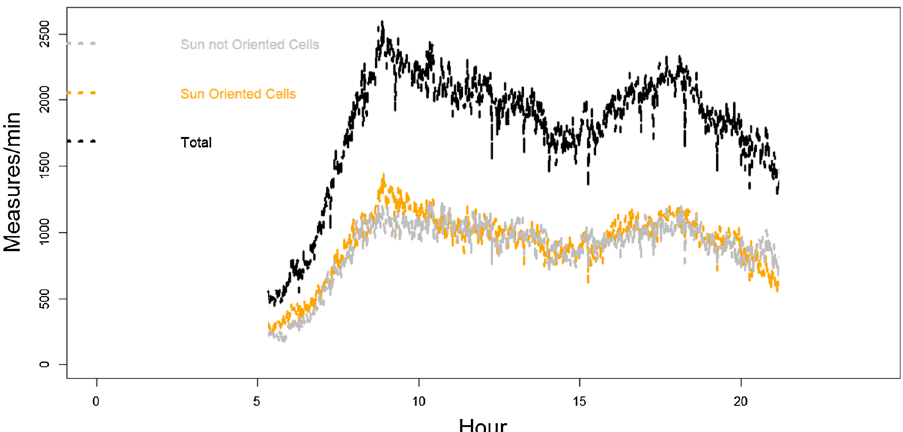
Figure 13. Example (Bologna area) of the total number of connections (in black) during the sunlight hours of the 2nd of July (no Sun flare). The gray line identifies the part of the connection related to non-Sun-exposed BS cells, whereas the orange line identifies the part of the connection related to Sun-exposed BS cells. Trends remain balanced all the